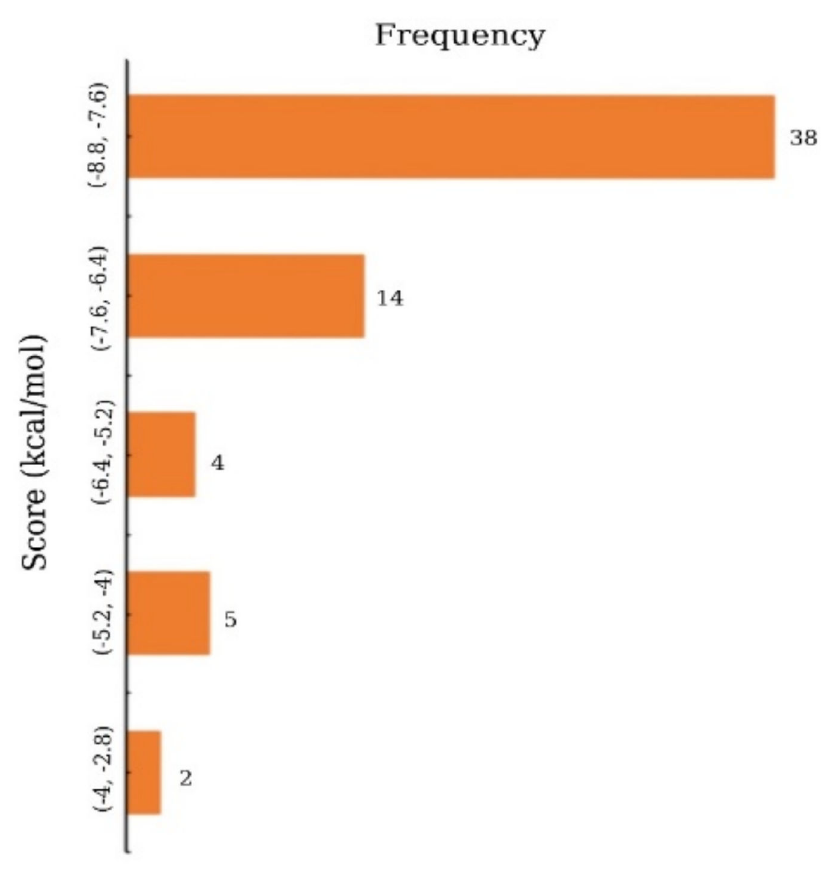
Figure 2. Frequency distribution of 63 phytochemicals over the range of docking